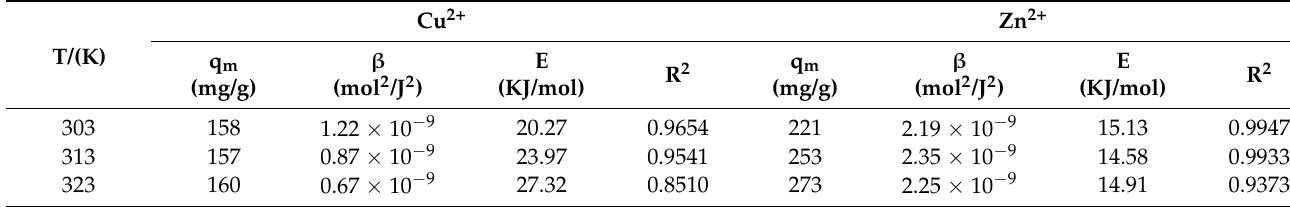
Table 5. Parameters of D-R isotherms for the adsorption of Cu 2+ and Zn 2+